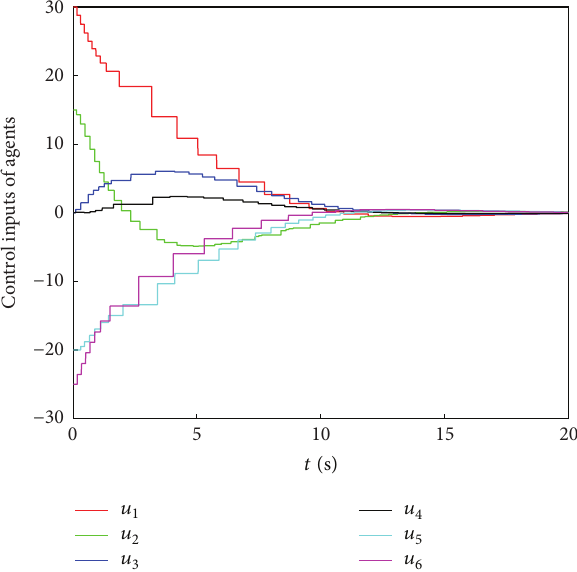
Figure 7: Control inputs of the CMVWT vehicles.